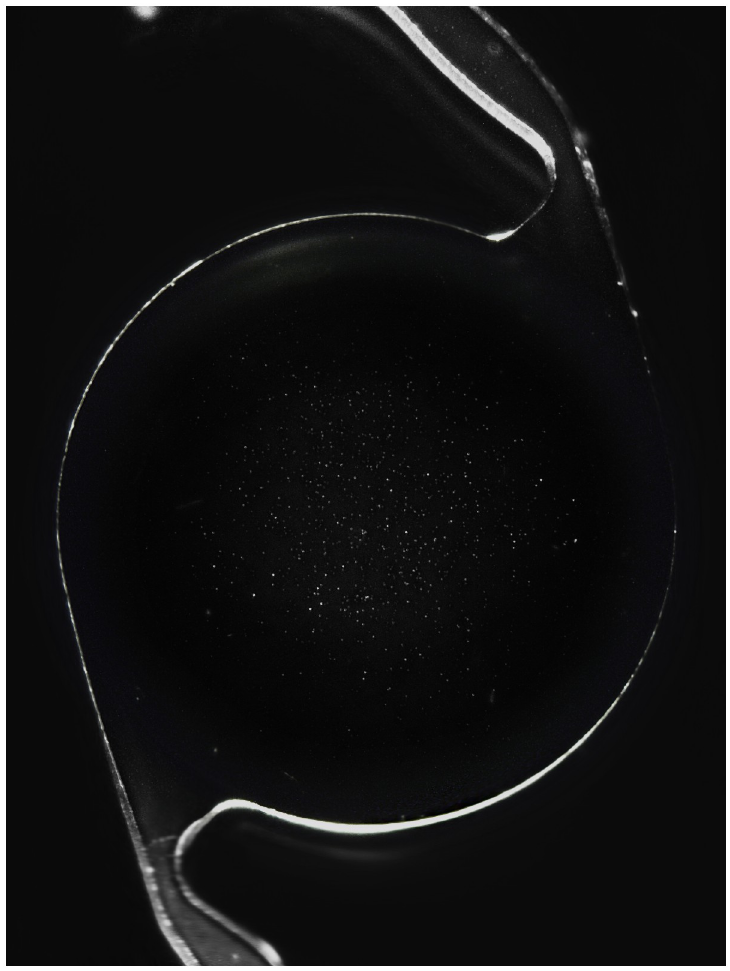
Fig 1. Overview image in 14x magnification of one of the SN60WF lenses after glistening induction. Glistenings are most numerous in the central part of the IOL